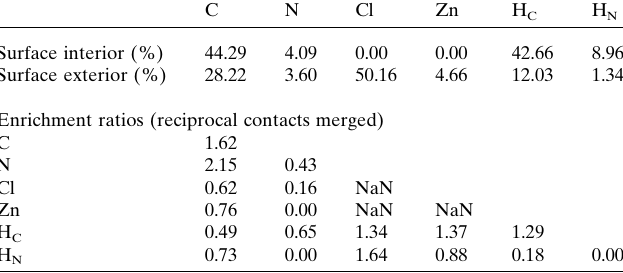
Table 6 Hirshfeld contact surfaces and ERs for (44TPH 3 ) 3+ . The H atoms bound to carbon (H C ) and nitrogen (H N ) are differentiated. The first column corresponds to ‘interior’ atoms and the remaining columns to ‘exterior’ ones.